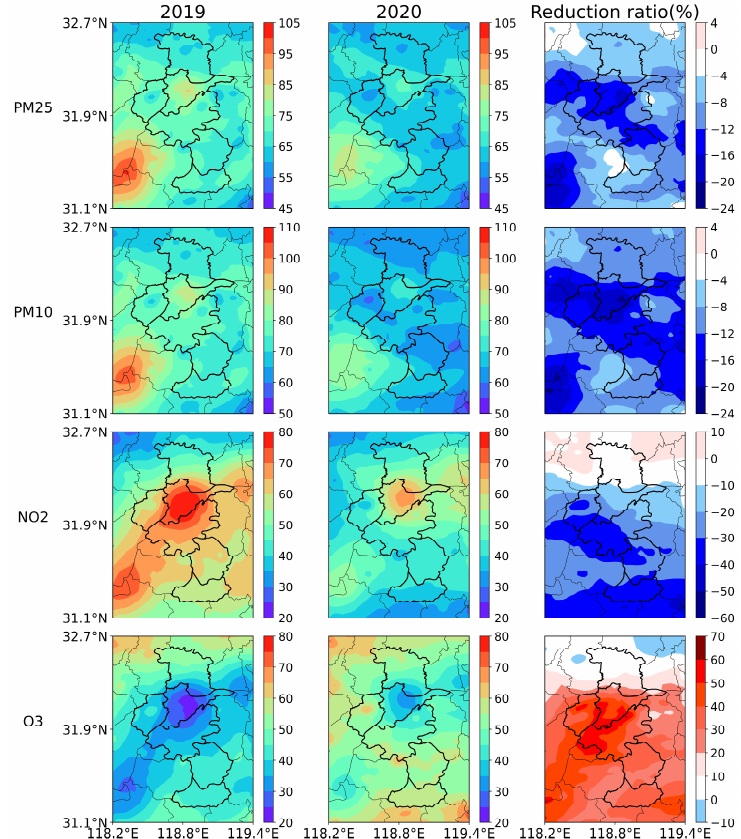
Figure 7. Spatial distribution of simulated mean near-surface NO 2 , O 3 , PM 2.5 , and PM 10 concentra- tions ( µ g/m 3 ) and percentage reduction in Nanjing during the NP and LP. Table 7. Average concentration and variation of pollutants during the NP and LP in Nanjing.